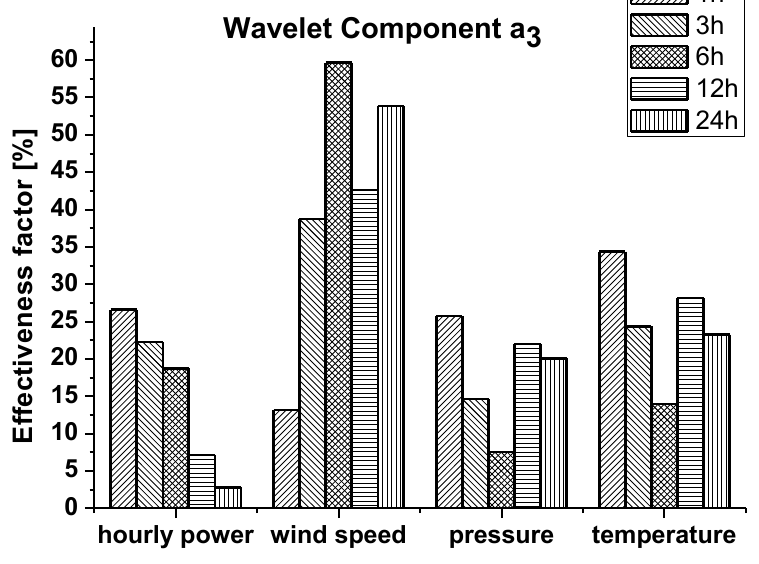
Figure 12. Histogram of the effectiveness factors for the approximation component a